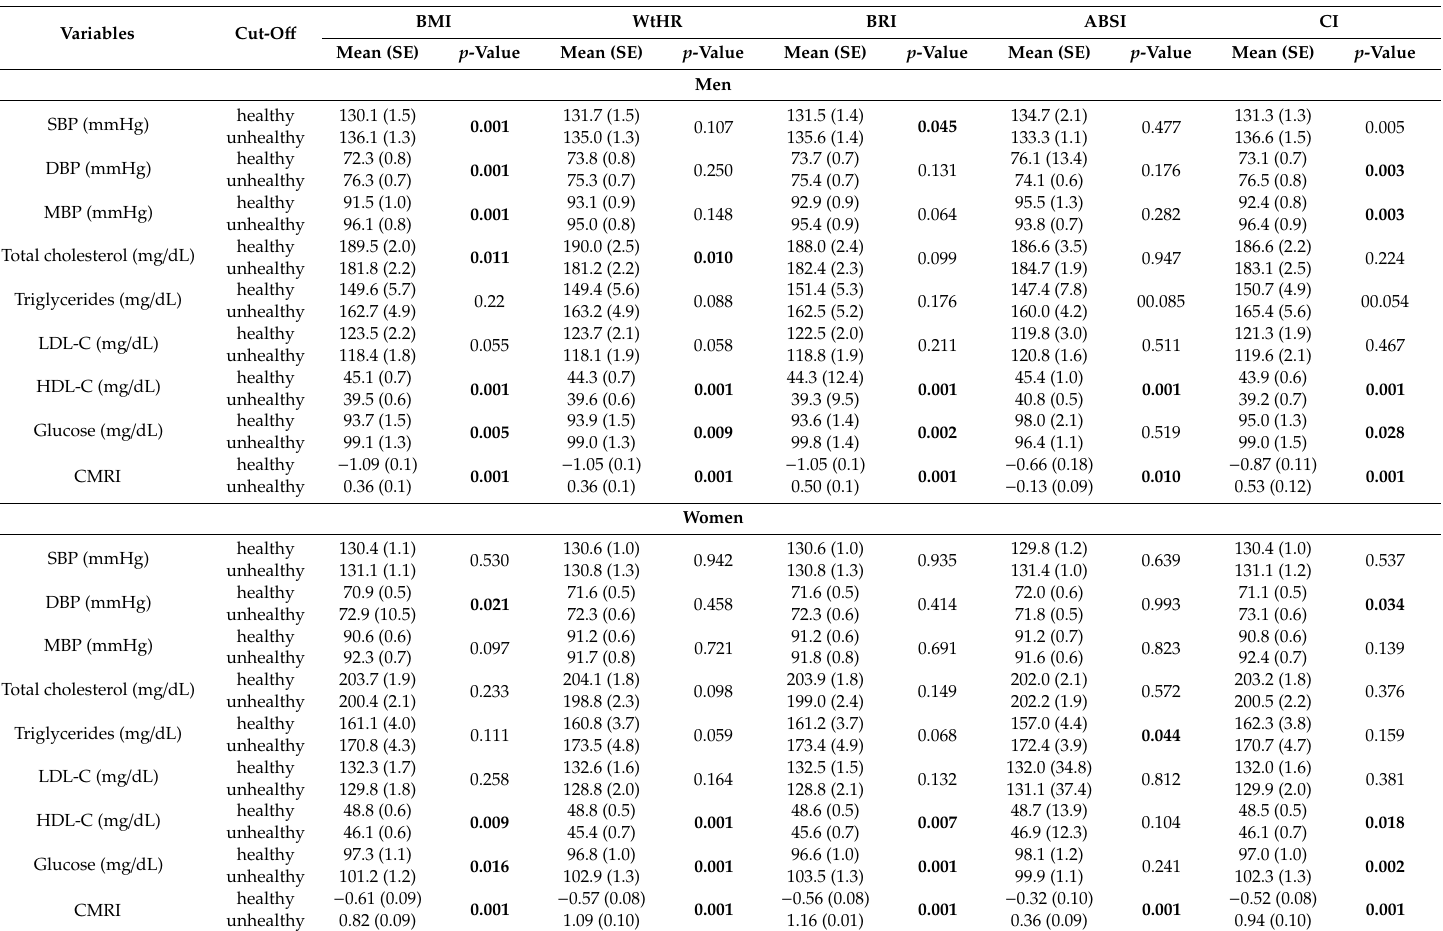
Table 4. Adjusted thresholds for surrogate anthropometric indices with cardiometabolic measurements among Colombian older adults by sex.